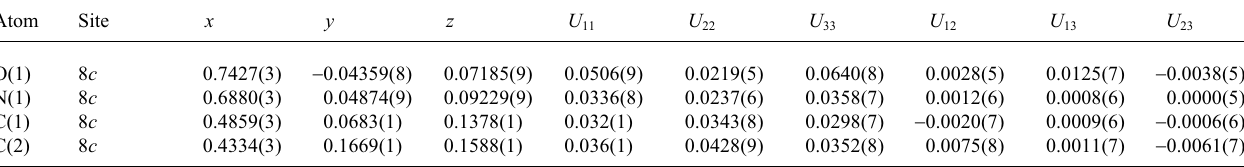
Table 3. Atomic coordinates and displacement parameters (in Å 2